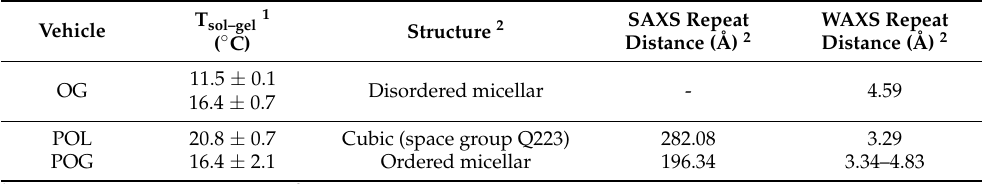
Table 2. Rheological and diffraction parameters of the indicated forms.